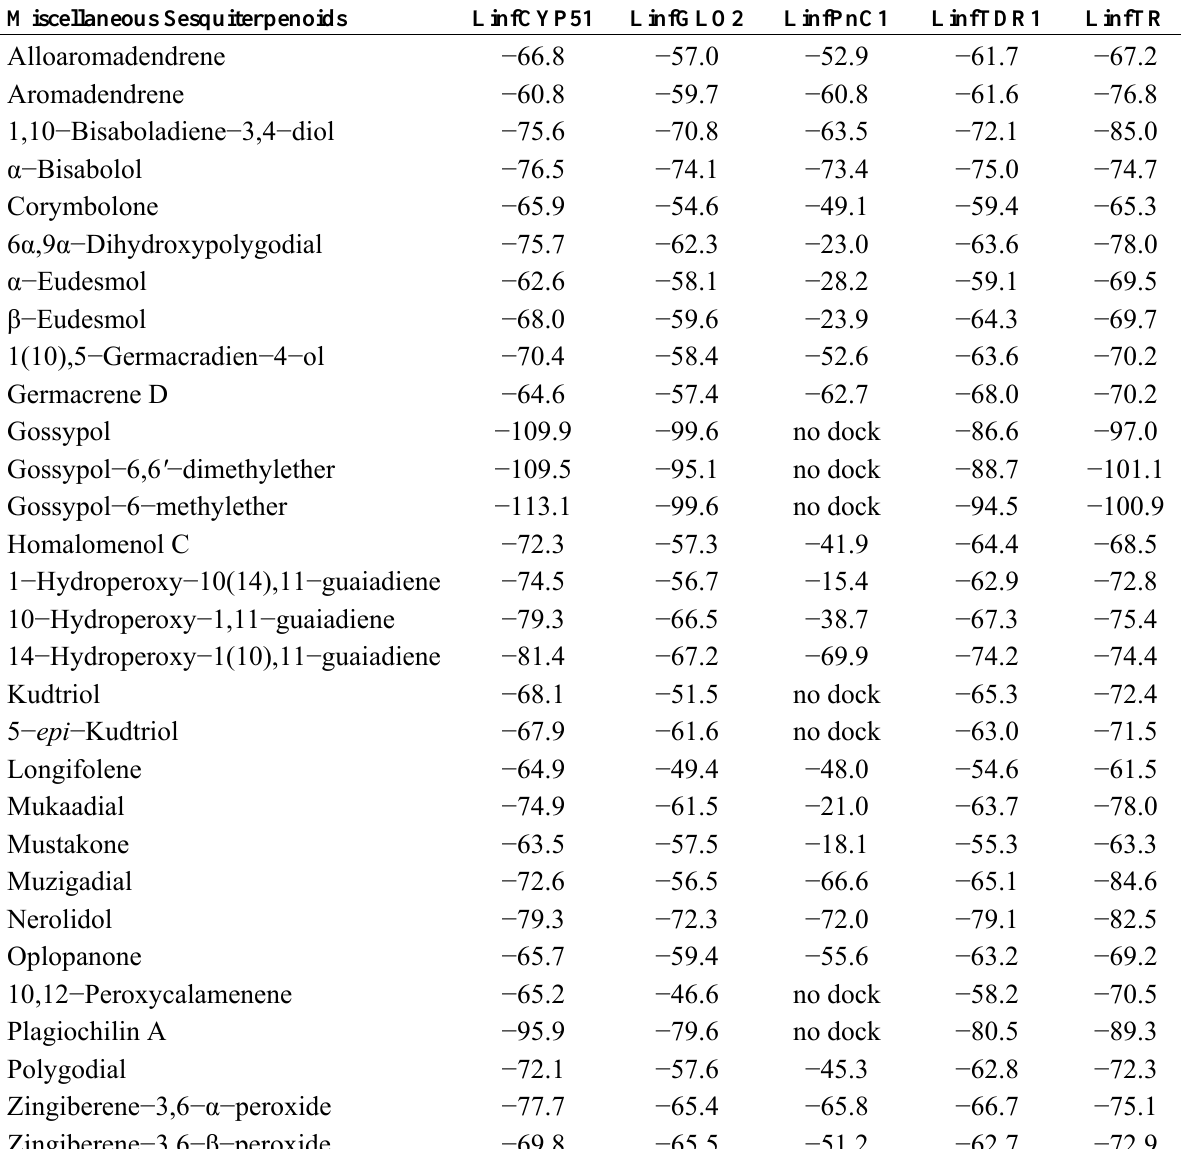
Table 15. MolDock docking energies (kJ/mol) of miscellaneous sesquiterpenoids with Leishmania infantum protein